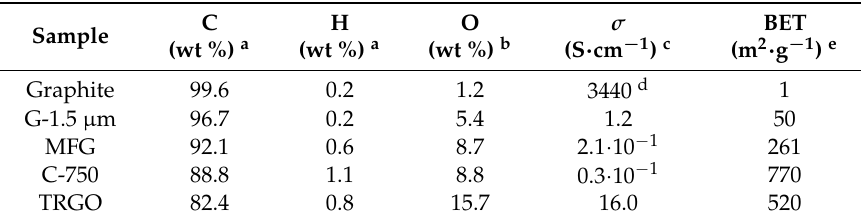
Table 1. Properties of the carbon fillers.